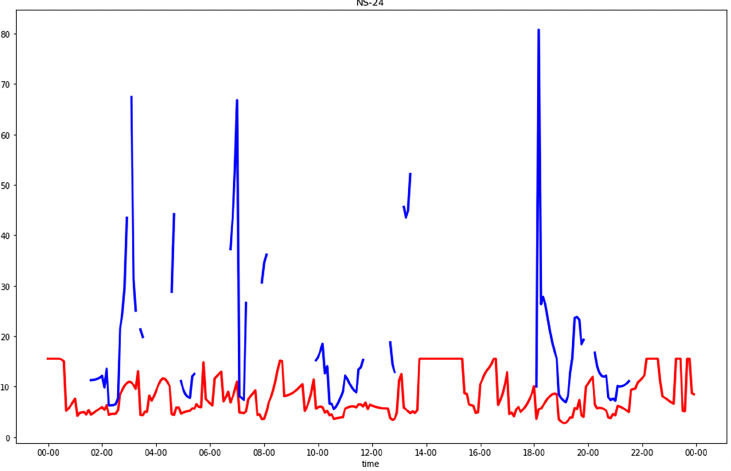
Figure 8. PDOP in north-south urban canyon for GNSS-alone compared with GNSS + five 5G stations, plotting only results with PDOP < 100.